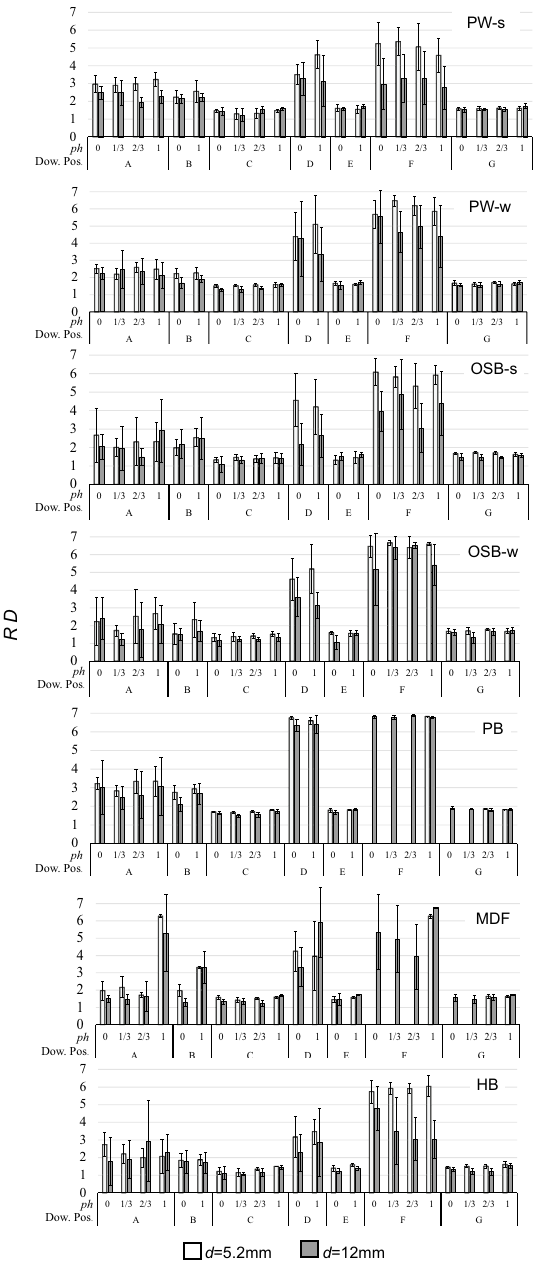
Fig. 10 Comparison of RD values. Dow. Pos. indicates the dowel position. Error bars indicate standard deviation